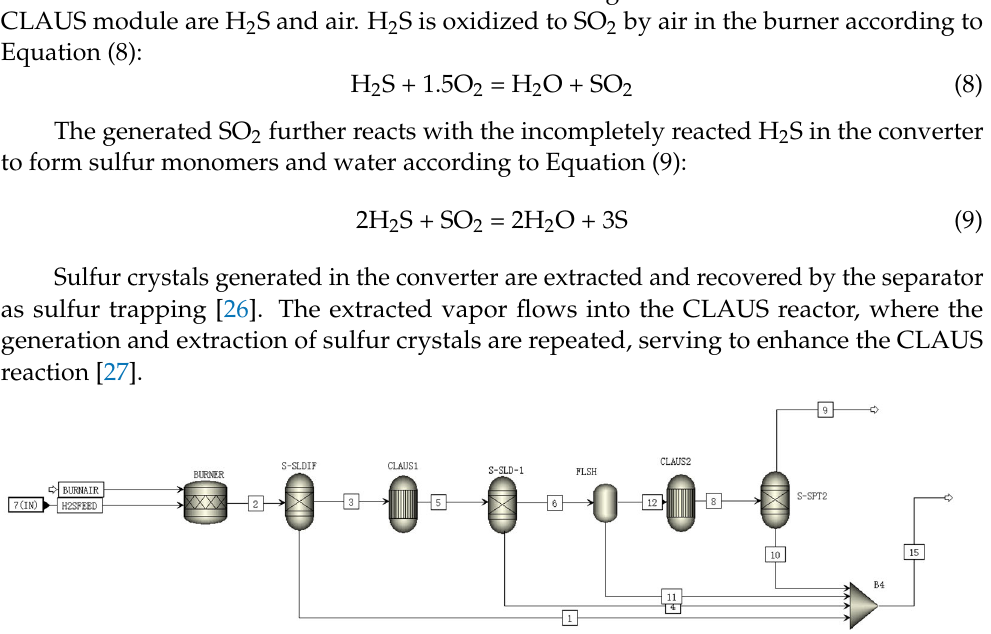
Table 2. Stream parameters in SHIFT.